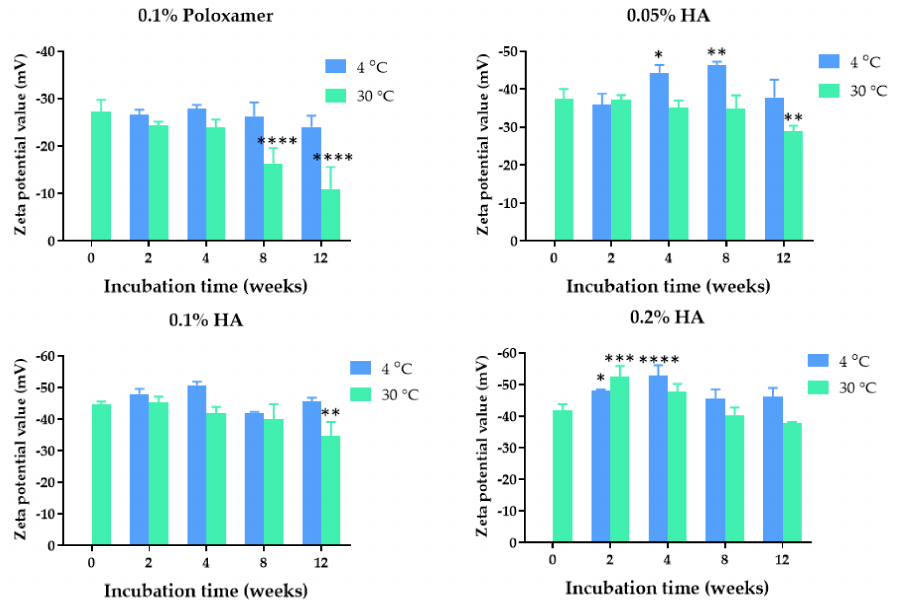
Figure 3. Zeta potential values of the quercetin-loaded PLGA NPs after fresh preparation and storage in deionized water for 2, 4, 8, and 12 weeks at 4 ◦ C and 30 ◦ C. *, **, *** and **** indicate p < 0.05, 0.01, 0.001, and 0.0001 compared with day 0,